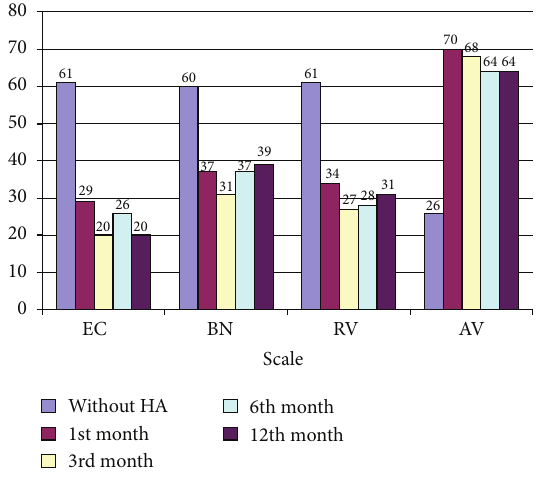
Figure 5: APHAB results.